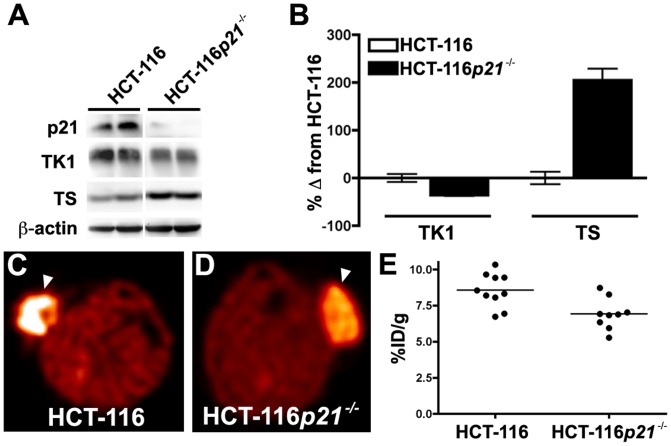
Isogenically matched cell line xenografts illustrate that de novo pathway utilization results in decreased [18F]-FLT uptake.Western blot analysis illustrated reduced TK1 levels and elevated TS levels in HCT-116p21
-/- xenografts compared to wild type HCT-116 xenografts (A). Densitometry of the western blot illustrated that HCT-116p21-/- tumors exhibited one-third less TK1 protein and double the TS protein compared to the parental line (B). Illustrating the sensitivity of [18F]-FLT PET to de novo pathway utilization, PET imaging of HCT-116 (C) and HCT-116p21-/- (D) xenografts closely reflected the relative tumor cell TK1 levels inherent to each model (tumor localized by arrowhead). HCT-116 xenografts (8.56 ± 1.17 %ID/g) exhibited approximately 1/3 greater uptake than analogous HCT-116p21-/- xenografts (6.91 ± 1.07 %ID/g; p  =  0.005) (E).